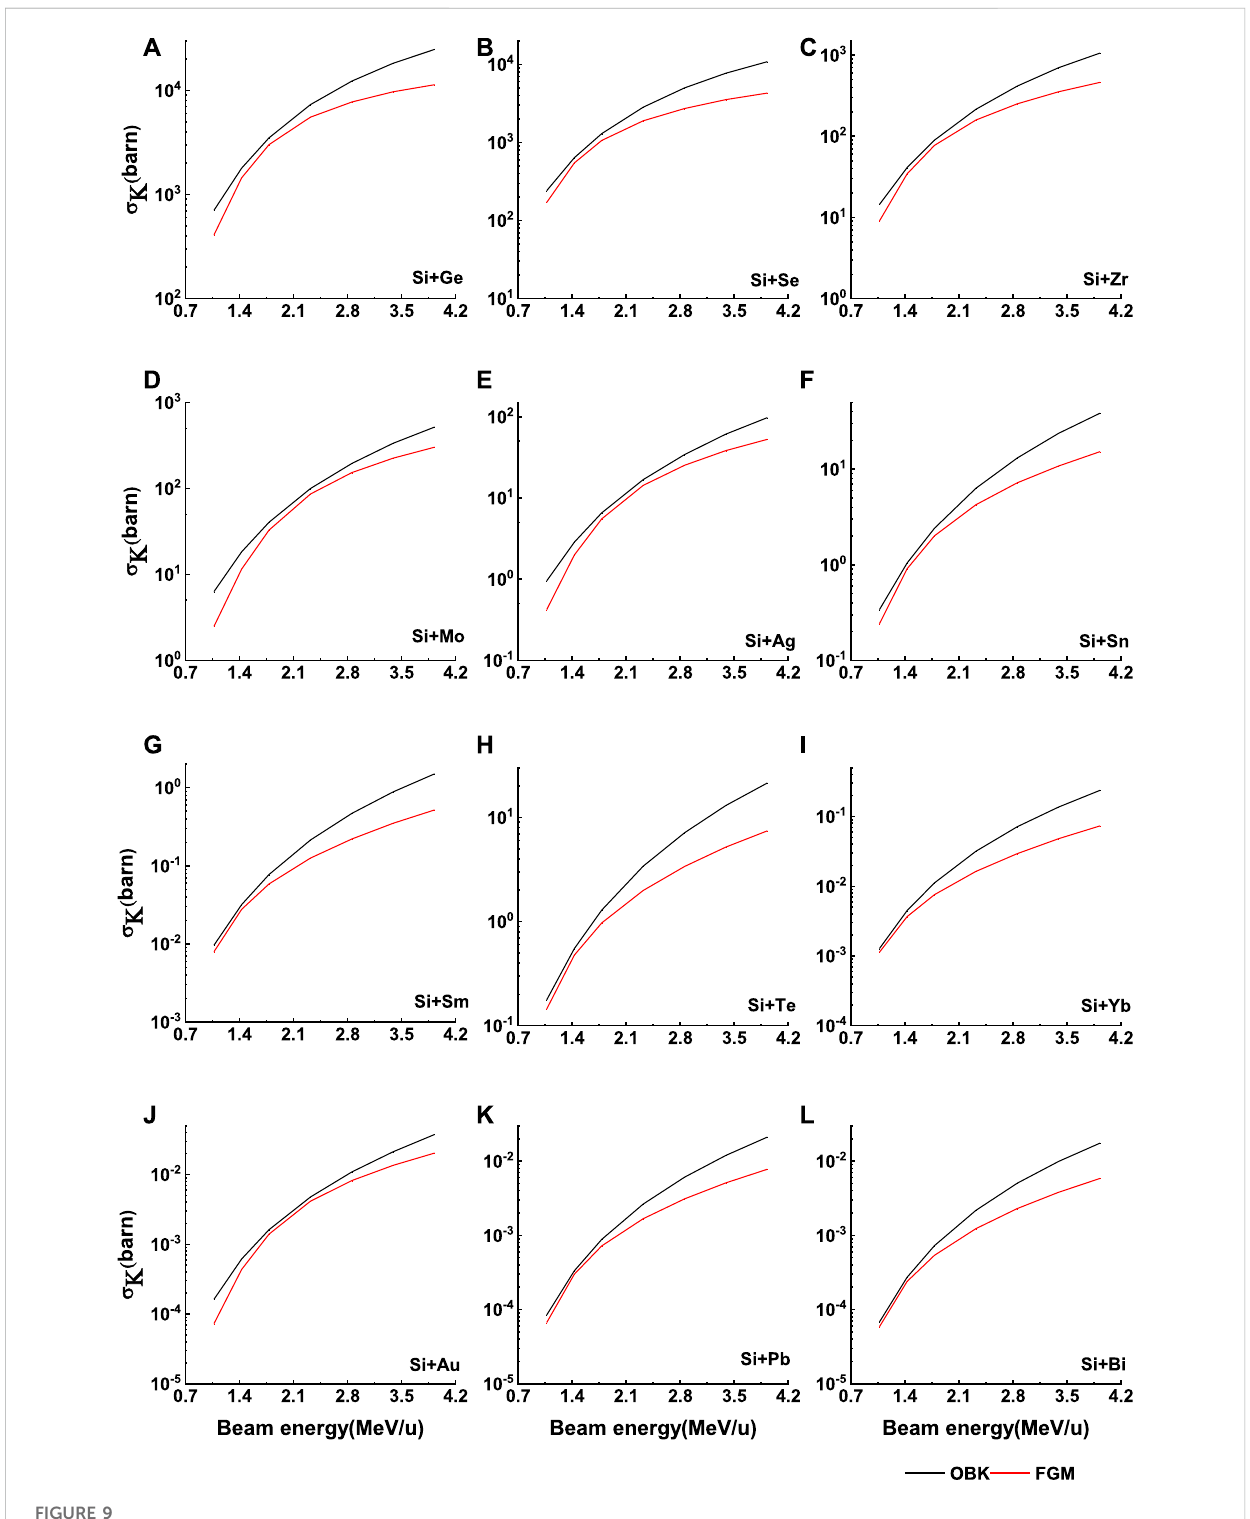
FIGURE 9 Theelectroncapturecrosssectionsobtained fromOBKapproximationandF-G-Mpredictionfordifferenttargets(fromGetoBi)bombardedbySi 28 ions as a function of ion beam energies (A-L) . The solid lines are to guide the eye only.